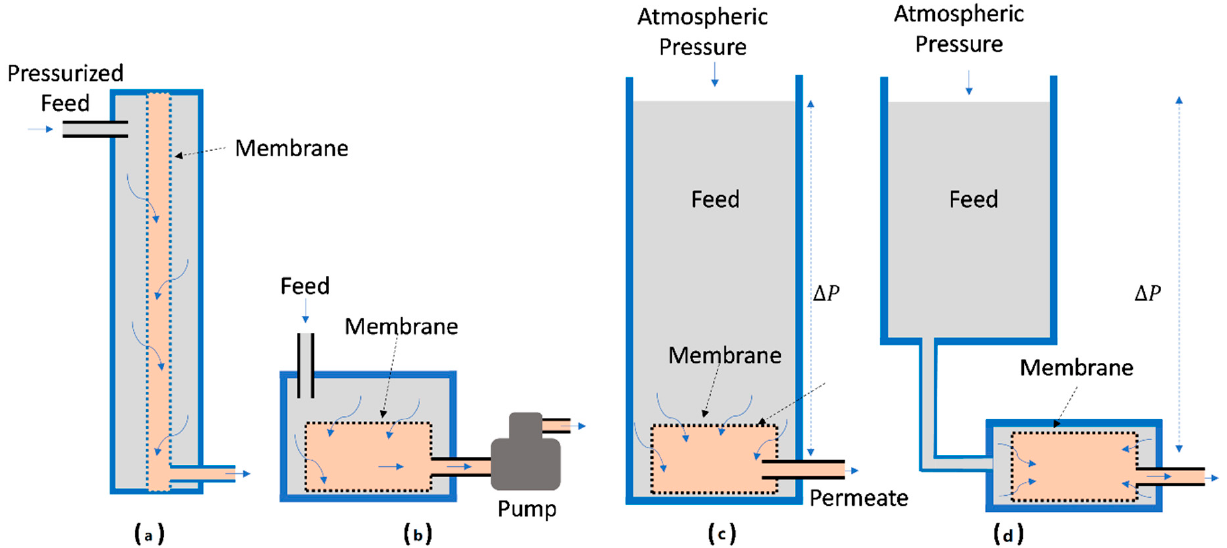
Figure 1. Basic illustrations of ultra-low-pressure membrane filtration system driven by mechanical and hydrostatic pressure showing ( a ) pre-pressured feed, ( b ) vacuum system involving permeate pump and gravity-driven with ( c ) internal and ( d ) external membrane placements.